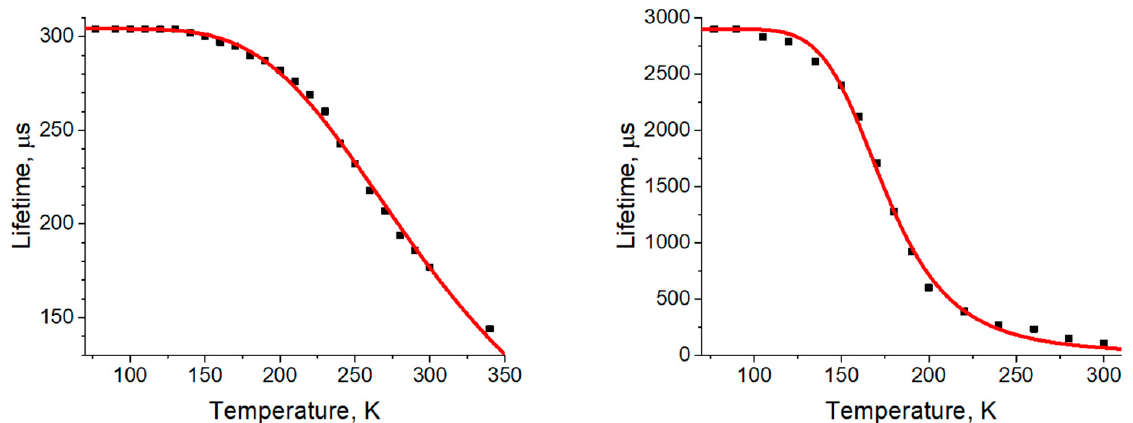
Figure 3. Temperature dependences of the photoluminescence lifetime of 1 ( λ Ex = 453 nm, λ Em = 520 nm, left) and 2 ( λ Ex = 447 nm, λ Em = 527 nm, right).